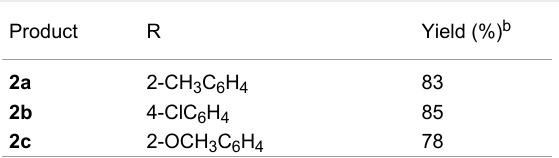
Table 3: Synthesis of 7-amino-2,3-dihydro-2-thioxo-1,3-diarylquina- zolin-4(1 H )-ones a . Product